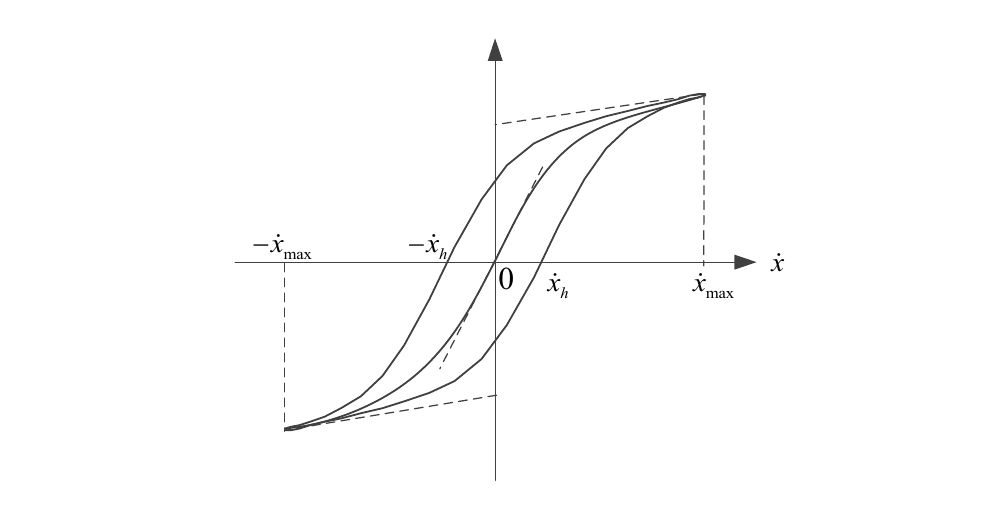
Figure 8. The undetermined parameters of the sigmoid model.